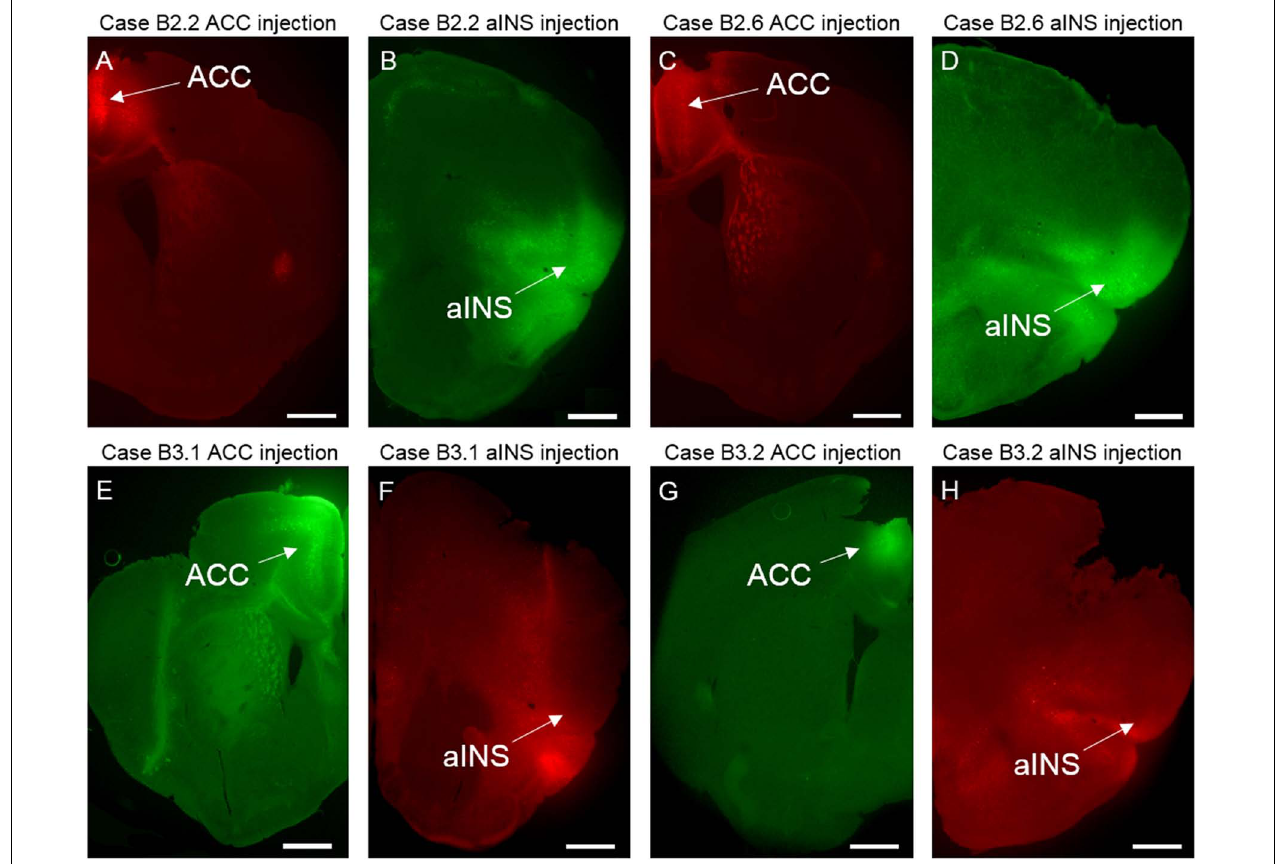
FIGURE 2 | Photomicrographs of viral tracer injections for case B2.2 in ACC (A) and aINS (B) , for case B2.6 in ACC (C) and aINS (D) , for case B3.1 in ACC (E) and aINS (F) , and for case 3.2 in ACC (G) and aINS (H) . Scale bar: 1 mm.